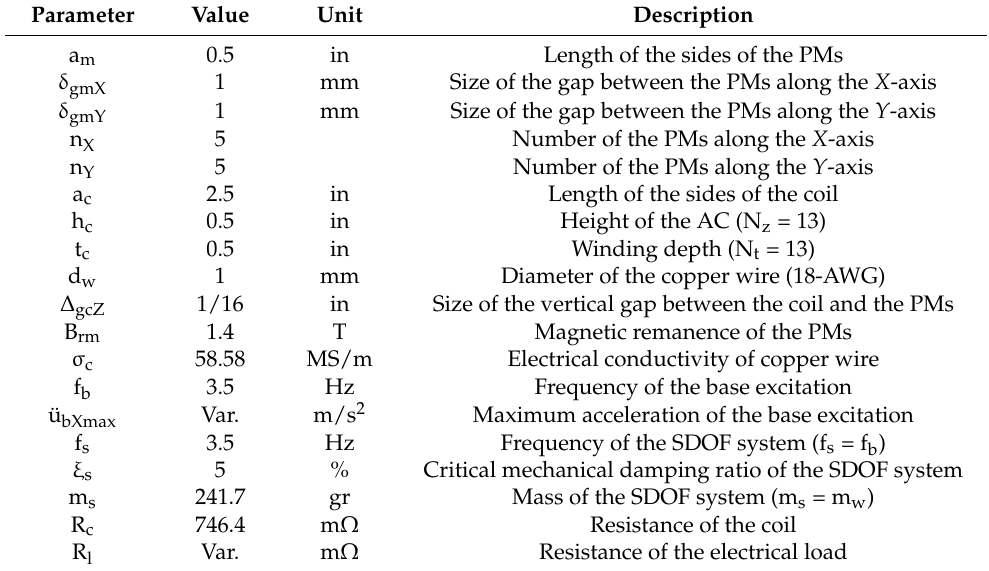
Table 3. Electromechanical parameters of the